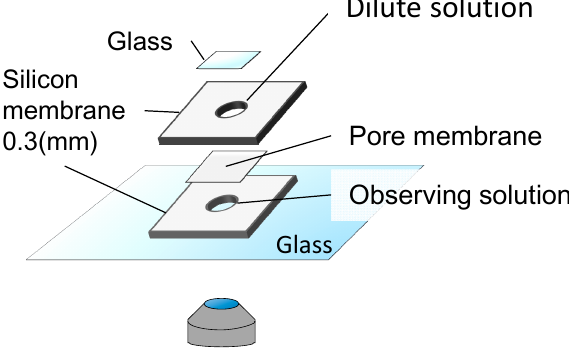
Figure 6. Schematic illustration of time-lapse observation under the application of tension.